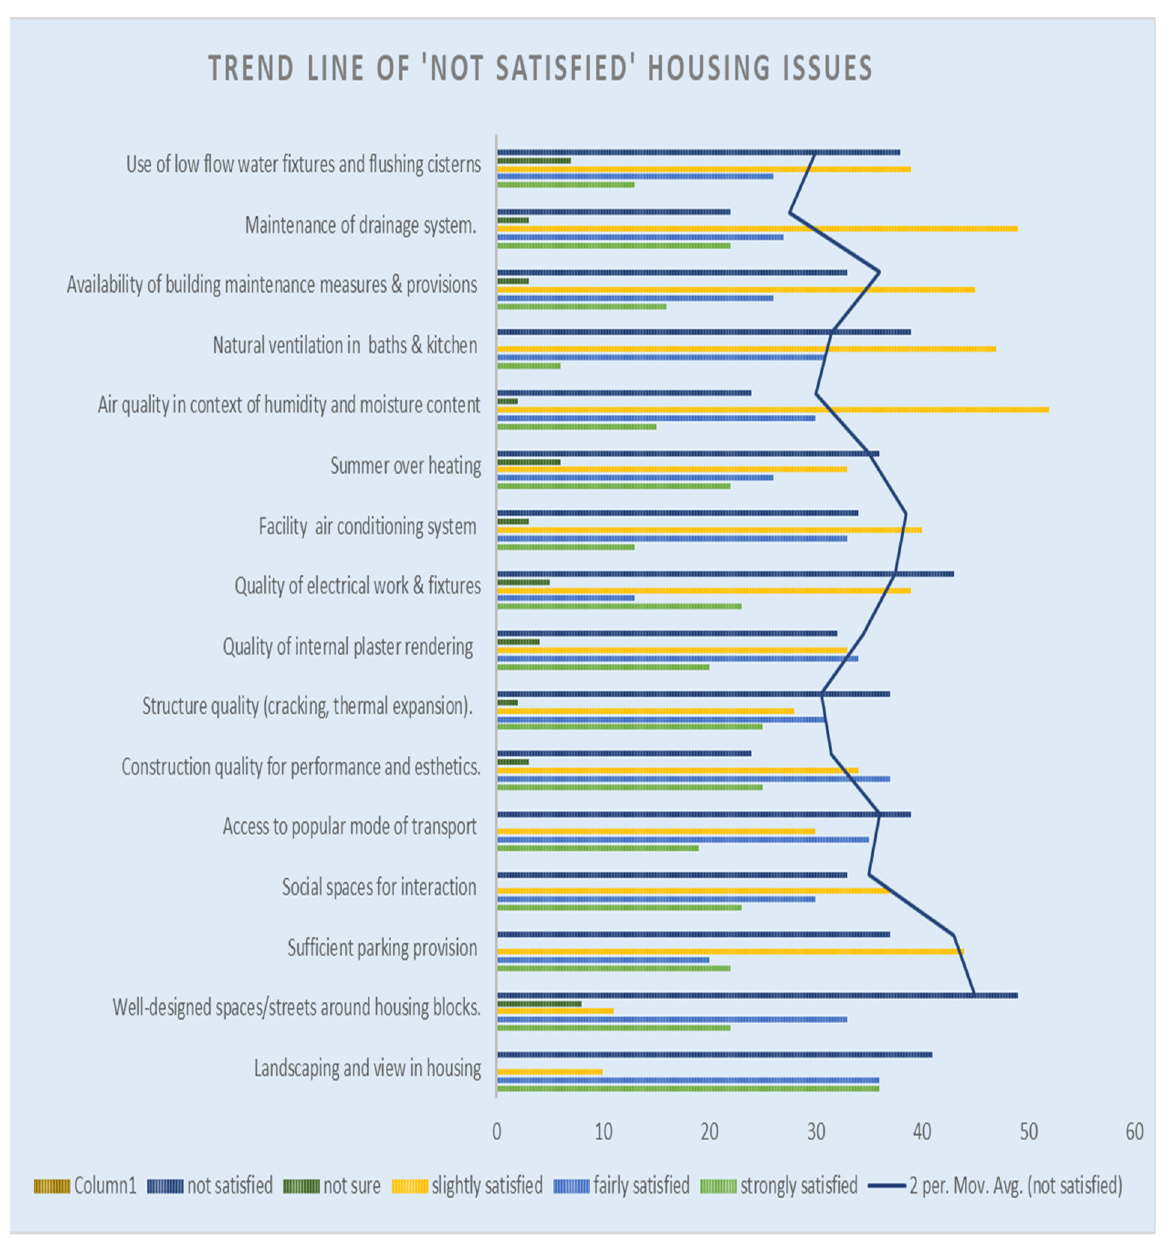
Figure 6. “Not satisfied” trend.